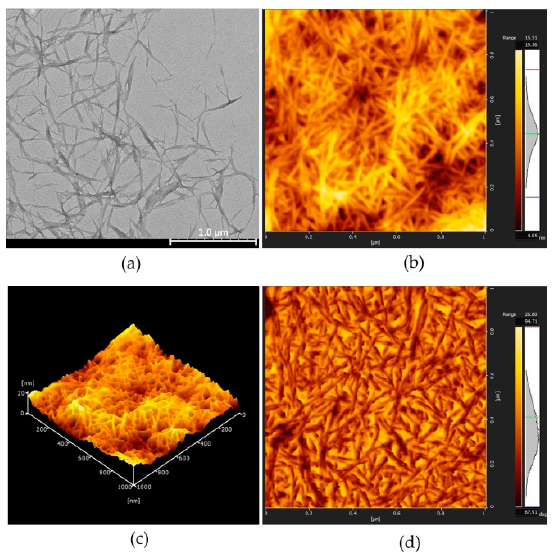
Figure 1. ( a ) Transmission electron microscopy (TEM) image; ( b ) atomic force microscopy (AFM) height image; ( c ) AFM 3D height image; ( d ) AFM phase image of cellulose nanocrystals (CNCs).